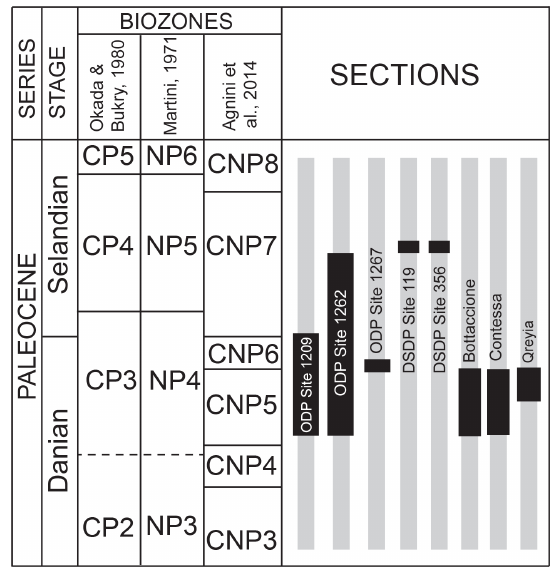
Figure 2. Stratigraphic intervals (in black) of the samples analyzed in this study correlated with the standard calcareous nannofossil zonations of Okada and Bukry (1980), Martini (1971), and Agnini et al.